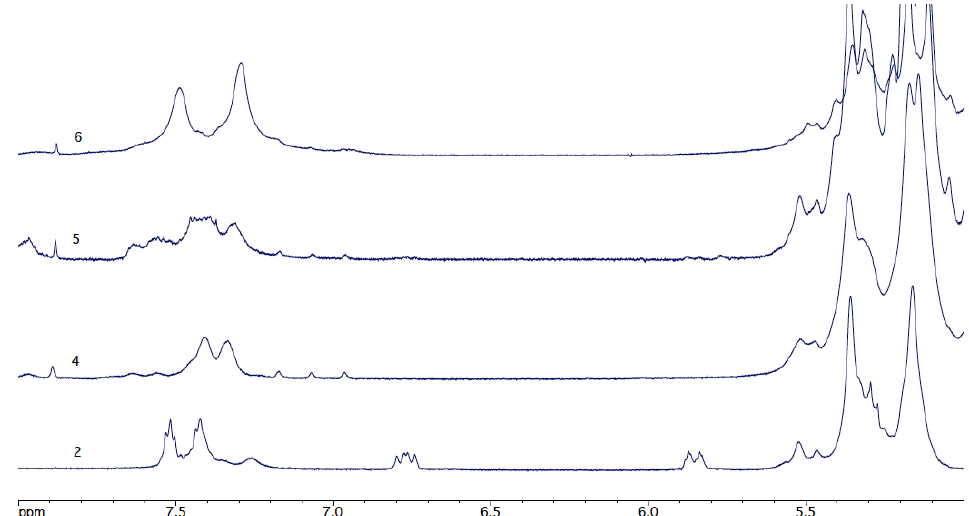
Figure 7. Stacked NMR spectra of 2, 4, 5, 6 in the vinyl and aromatic regions.